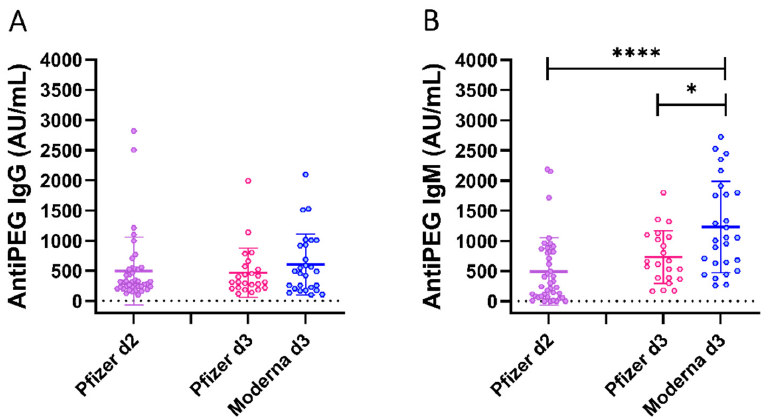
Figure 3. Comparison of anti-PEG IgG and IgM in subjects boosted with BioNTech/Pfizer or Moderna formulation. Anti-PEG IgG ( A ) and anti-PEG IgM ( B ) measured in heathy donors. All the volunteers